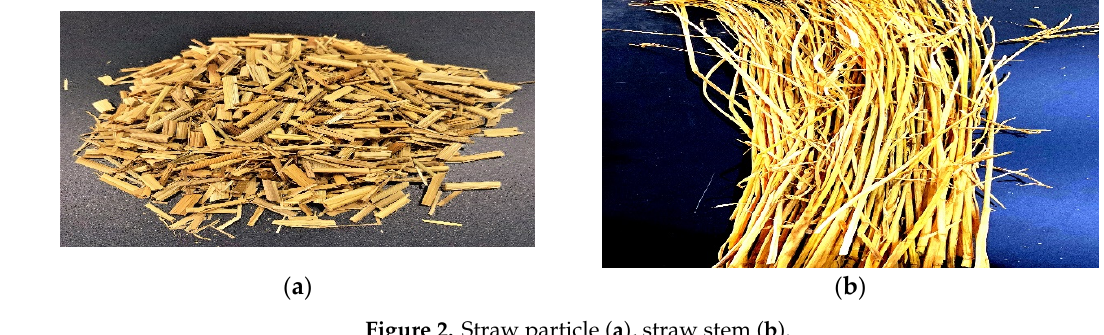
Figure 2. Straw particle ( a ), straw stem ( b ).